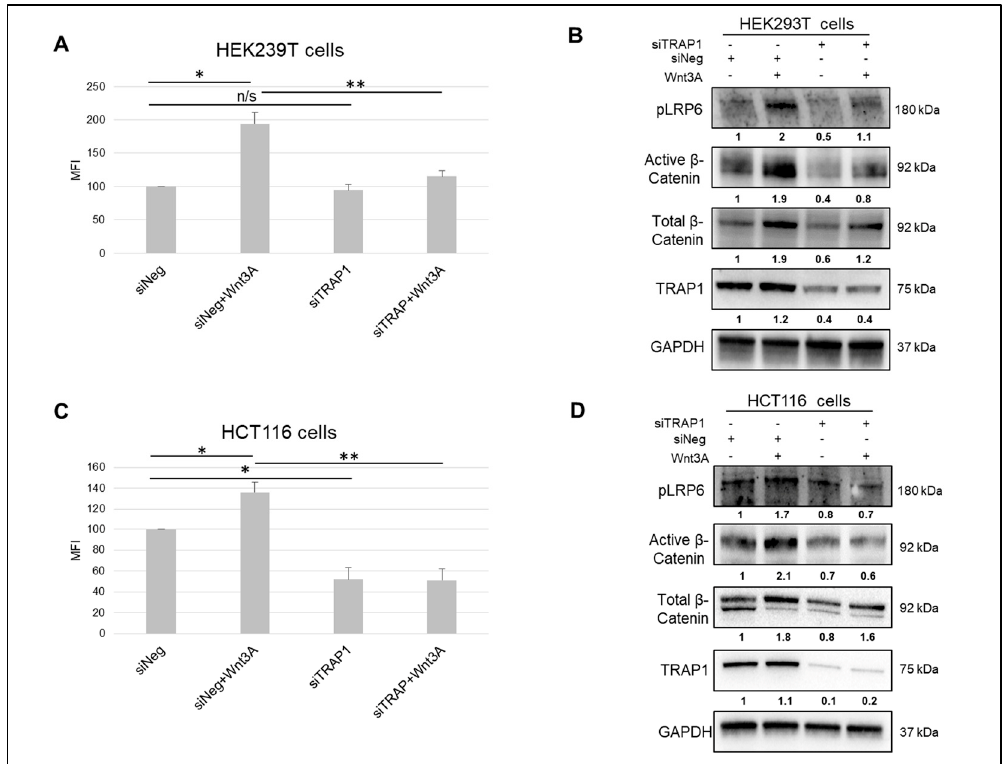
Figure 1. TRAP1 modulates the activity of Wnt/ β -Catenin pathway. ( A , C ) The activity of Wnt/ β -Catenin signaling was evaluated in control (siNeg) and TRAP1-silenced (siTRAP1) HEK293T (A) and HCT116 (C) cells, upon transfection with a Cignal TCF/LEF Reporter and subsequent stimulation with 150 ng / µ L Wnt3A recombinant protein for 6 h. Statistical significance respect to the respective control: * p < 0.05; ** p < 0.01; n/s, not significant. Data represent means + S.D. MFI, Mean Fluorescence Intensity. ( B , D ) Total lysates from control and TRAP1-silenced HEK293T (B) and HCT116 (D) cells, treated as reported in panels (A,C), were separated by SDS-PAGE and immunoblotted with indicated antibodies.